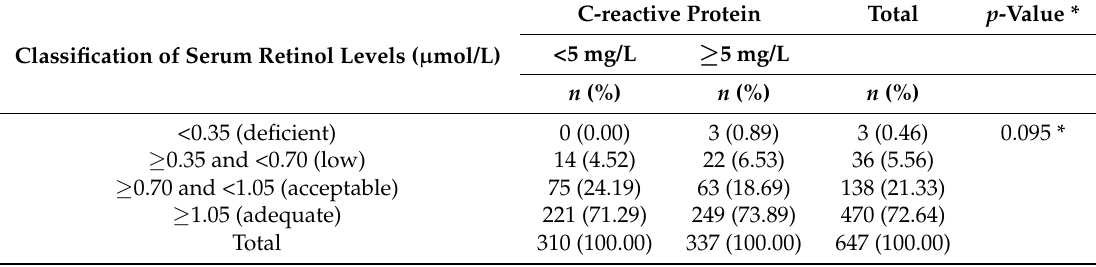
Table 2. Classification of serum retinol in the studied pregnant women according to C-reactive